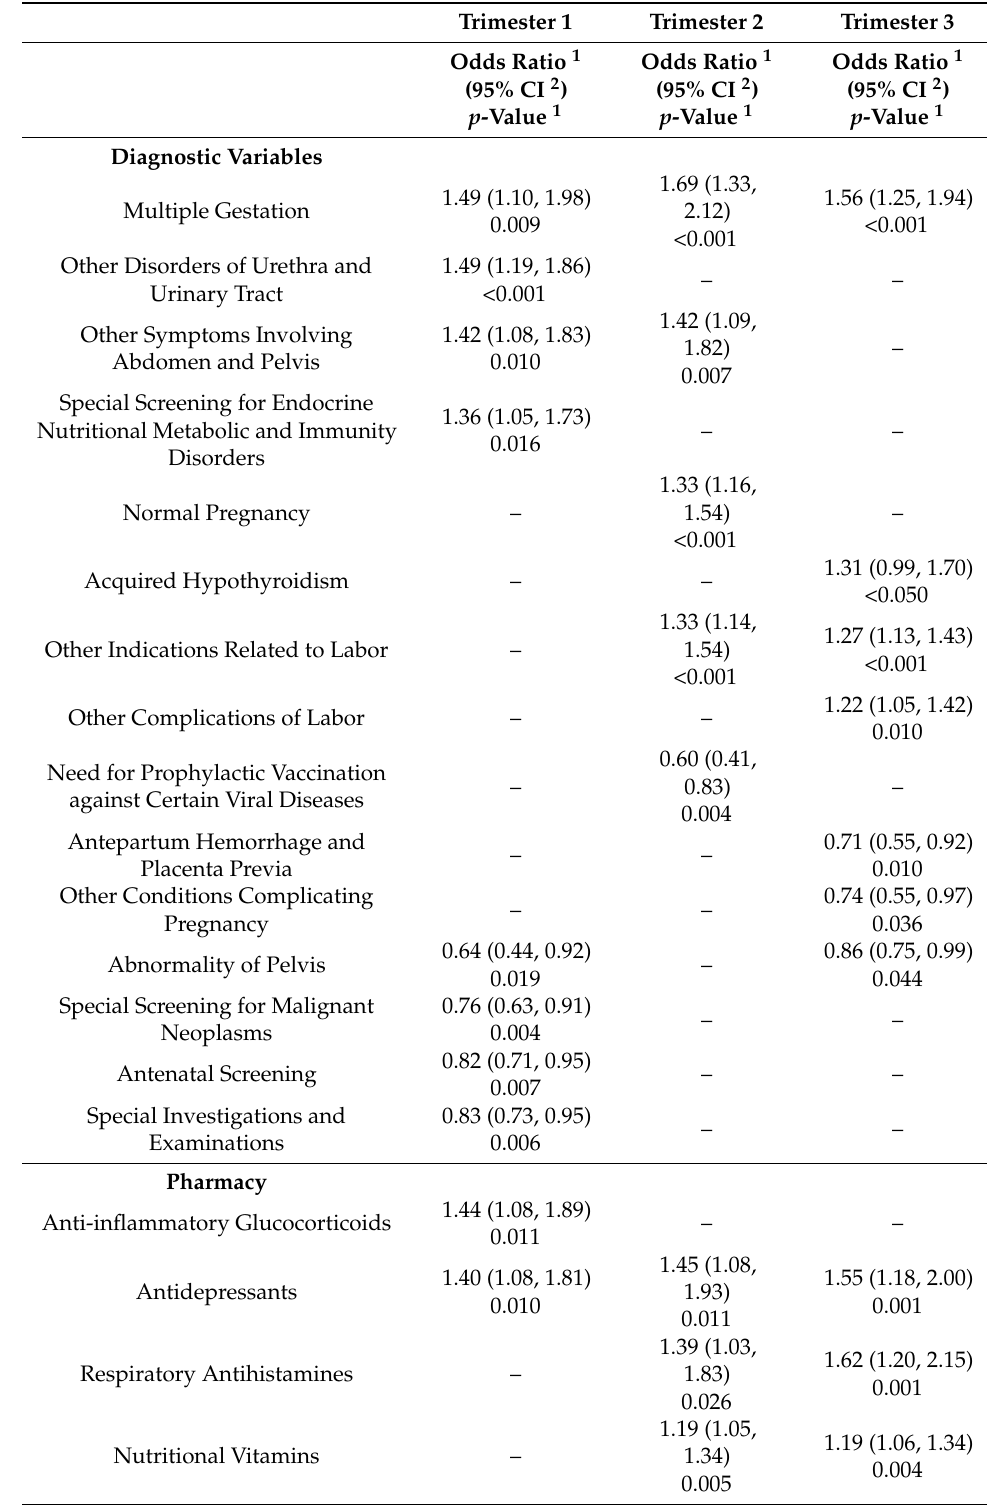
Table 8. Logistic Regression Analysis Results of Variables Identified as Highly Significant during each